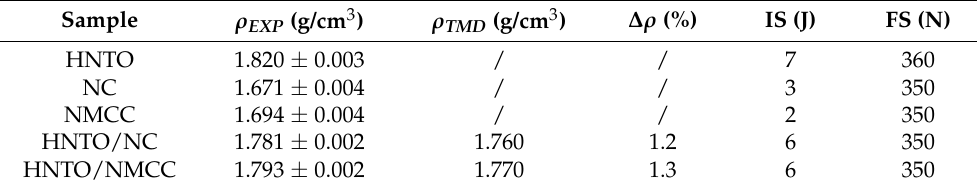
Table 1. Densities, impact and friction sensitivities of the investigated samples.